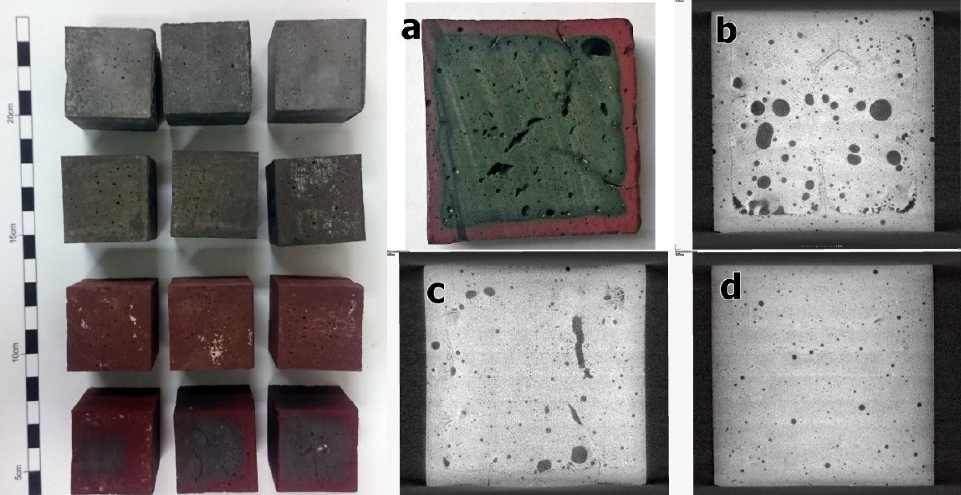
Figure 3. Geopolymer specimens ( left )—from top to bottom—control series, 400 °C, 800 °C, 1150 °C. Cross section of geopolymer specimen series VFM4.5 heated to 1150 °C: ( a ) regular camera view; ( b , c ) X-ray tomography images in mid-part of the specimen; ( d ) X-ray tomography image close to surface in oxidation layer.